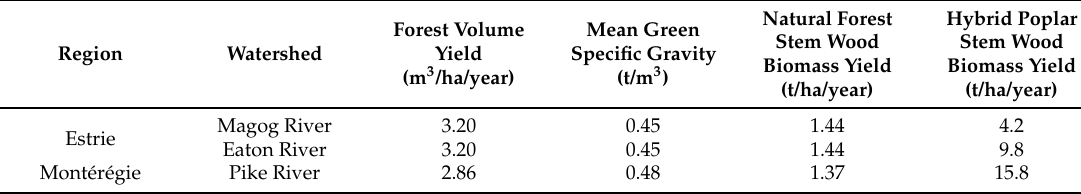
Table 4. Productivity, in terms of allowable cut (m 3 /ha/year), of natural privately owned forest in the study area and for the three studied watersheds [74,75], and its conversion into stem wood biomass productivity (t/ha/year). The assumed stem wood biomass productivity of hybrid poplar buffers is also indicated (based on data from Fortier et al. [42]).